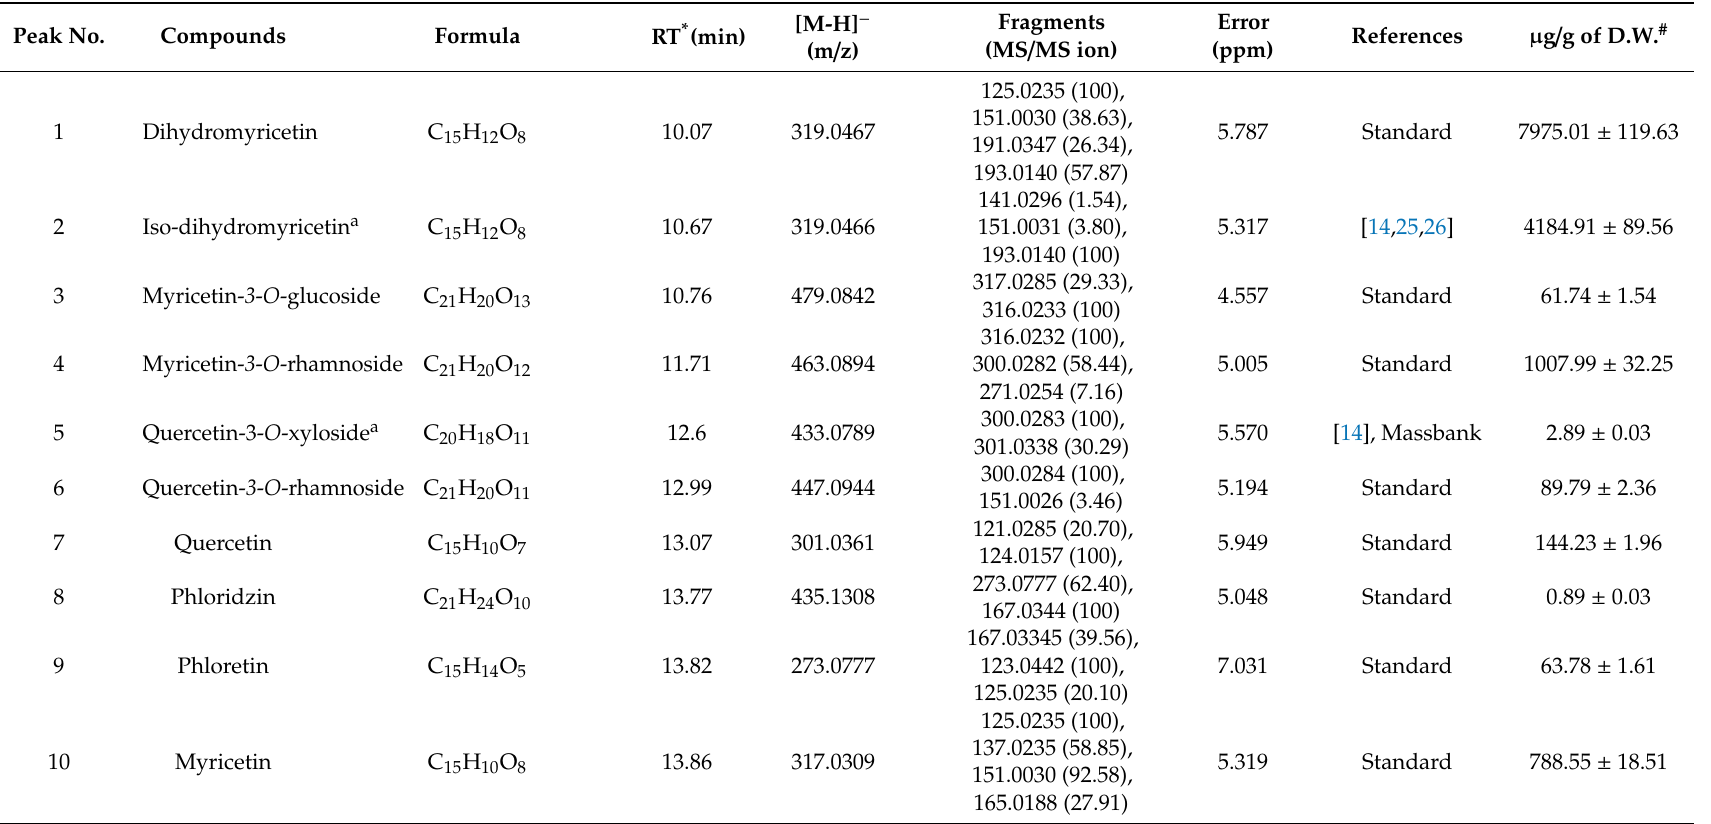
Table 1. Identification and quantification of main polyphenolic compounds in vine tea ( Ampelopsis grossedentata ) extract. Peak